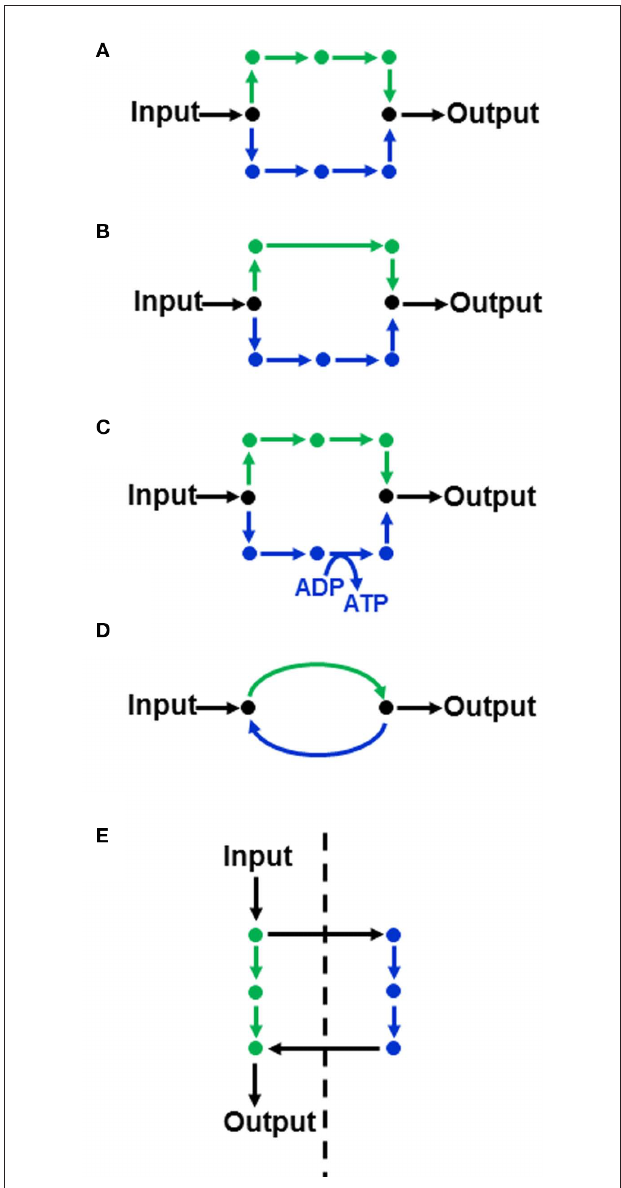
Figure 1 | Features of a metabolic network than can lead to flux variability in FBA. (A) Two equivalent routes (shown in green and blue) for converting an input substrate into an output metabolite. (B,C) illustrate non-equivalent routes that may be discriminated in FBA, depending on the objective function. (D) A substrate cycle. (e) Equivalent routes in different subcellular compartments (the dashed line indicating a membrane separating two